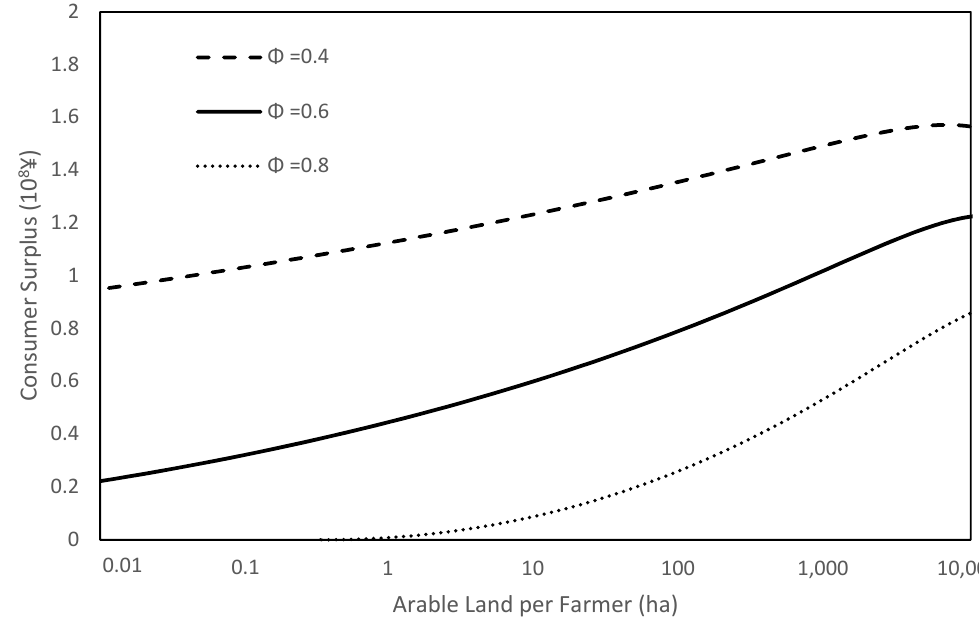
Figure 7. Relation of ALPF to consumer surplus. Note: Consumer surplus is calculated using the equilibrium price P mar and the demand curve, Equation (15) in Section 3.1.